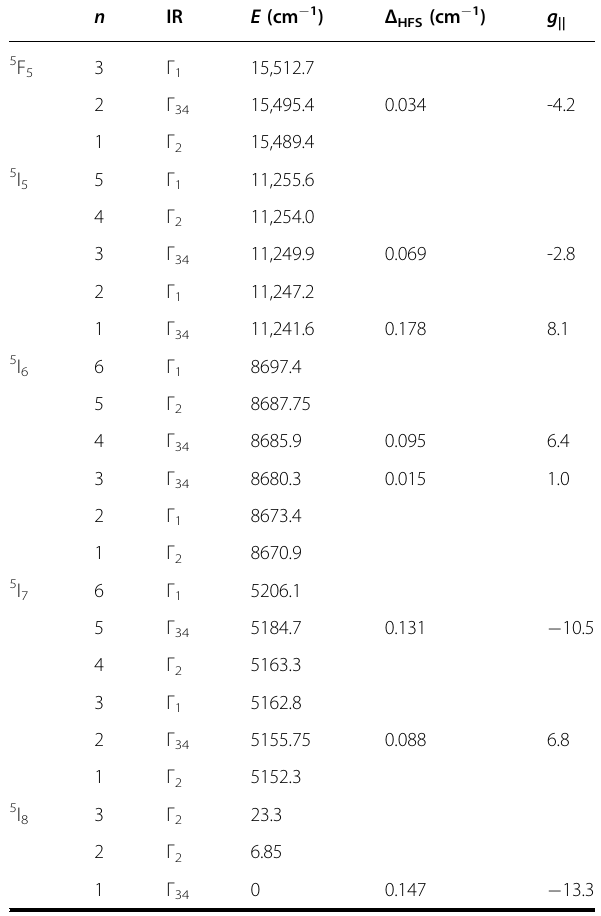
Irreducible representations IRs, crystal- fi eld energies E (cm − 1 ), average intervals of the magnetic hyper fi ne structure Δ HFS (cm − 1 ), and g factors of Γ 34 doublets, obtained from the analysis of the optical spectra of LiYF 4 :Ho 3 + (0.1 at. %). 0.6 δσ . The measured line shape is a convolution of a real line shape and the instrumental function f shape practically does not change down to W = 2 δσ ( W is FWHM of the studied spectral line). At W = δσ , weak